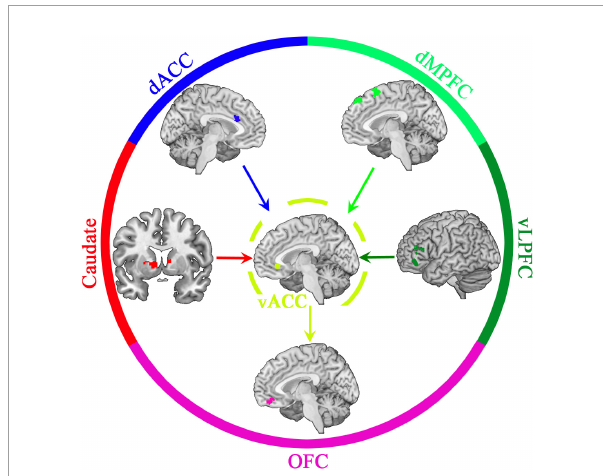
FIGURE4 Positive illusion (seeing one’s partner generously) emergence in the brain and its subsystem. The caudate nucleus highlights the positive features of a romantic partner compared to negative features or other social comparisons. Decreased dACC activation suppresses the perception of negative characteristics of the partner. In the meantime, the dMPFC and vLPFC lessen the prominence of tempting rivals. Then the vACC intensifies the distinction between the favorite social features of intimate people and other people. Finally, when information is transmitted to the OFC, the weight of a partner’s positive and negative characteristics is re-assessed, reinforcing biased, subjective values (e.g., positive illusion) about the romantic partner—reprinted with permission (Song et al., 2018).